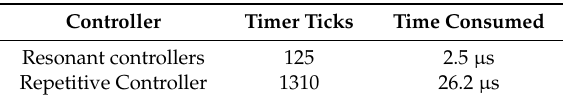
Table 1. Computational burden.